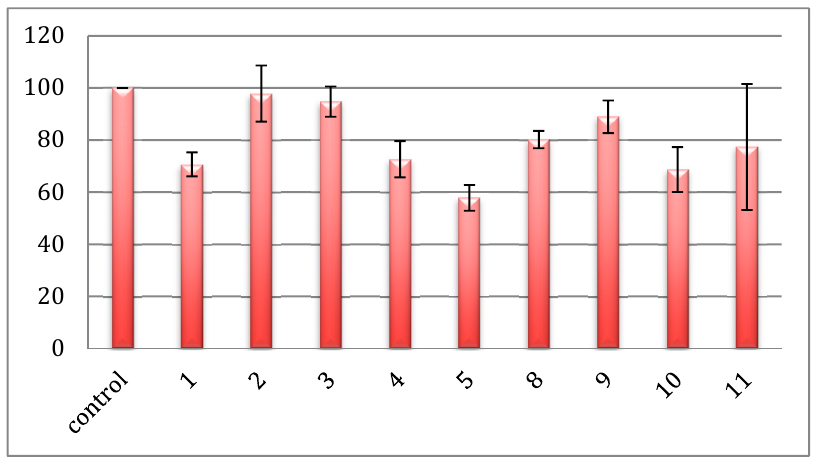
Figure 4. Anti-GST activity of test compounds at the concentration of 10 µM.